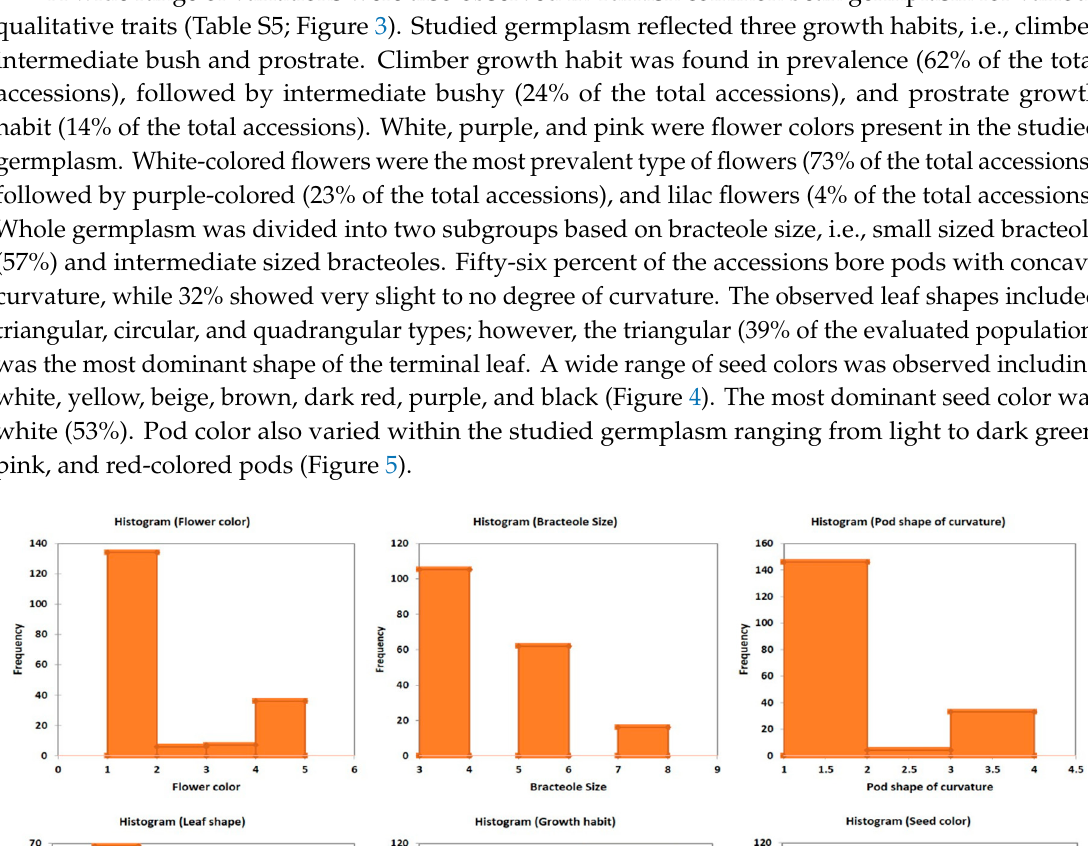
Figure 4. Pods size, shape, and color diversity in Turkish common bean germplasm.